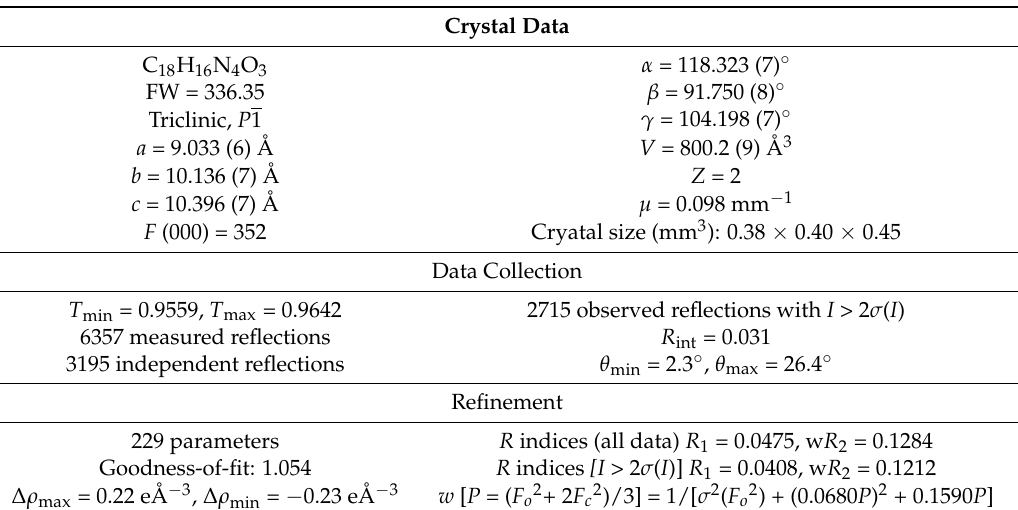
Table 1. Crystal data of title compound 4n